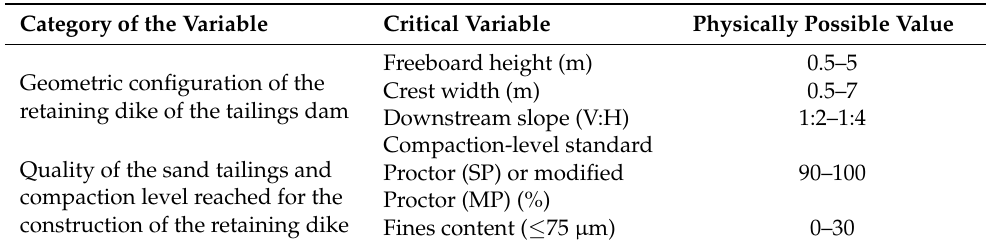
Table 2. Physically possible values for continuous geometrics and geotechnical control critical variables that define PS in STD from medium-sized Chilean mining. According to